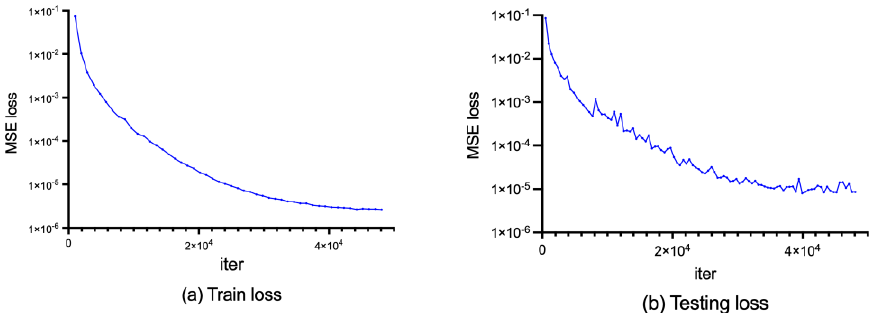
Figure 10. Train and test loss using MSE loss: ( a ) the train loss, the loss converges nearly ( b ) the test loss, the loss converges nearly 8.51 × 10 − 6 . MSE loss made the model converge quickly 2.64 × 10 −6 ; ( b ) the test loss, the loss converges nearly 8.51 × 10 −6 . MSE loss made the model con- after 10 epochs within 10,000 batch verge quickly after 10 epochs within 10,000 batch iterations.